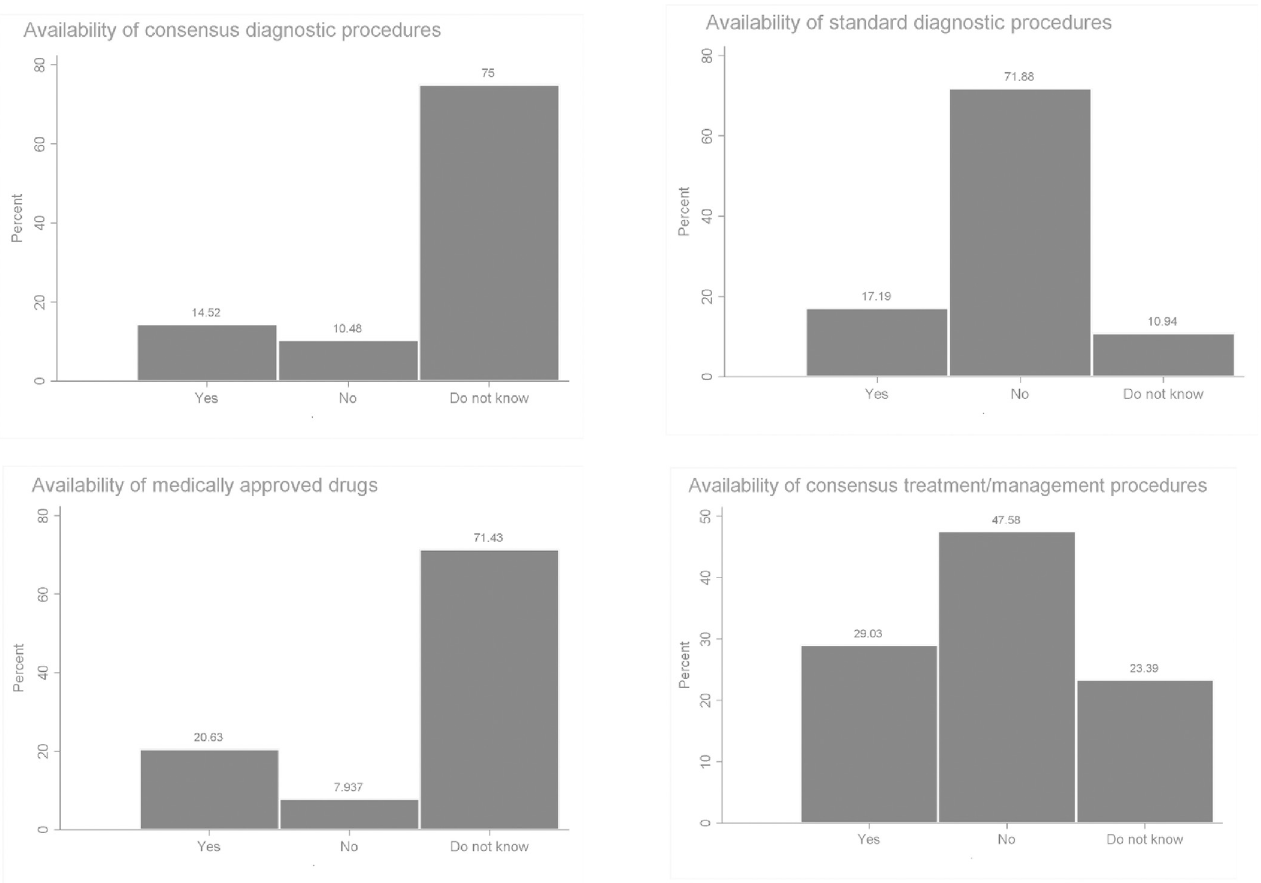
Fig 3. Mitochondrial disease diagnosis and treatment.